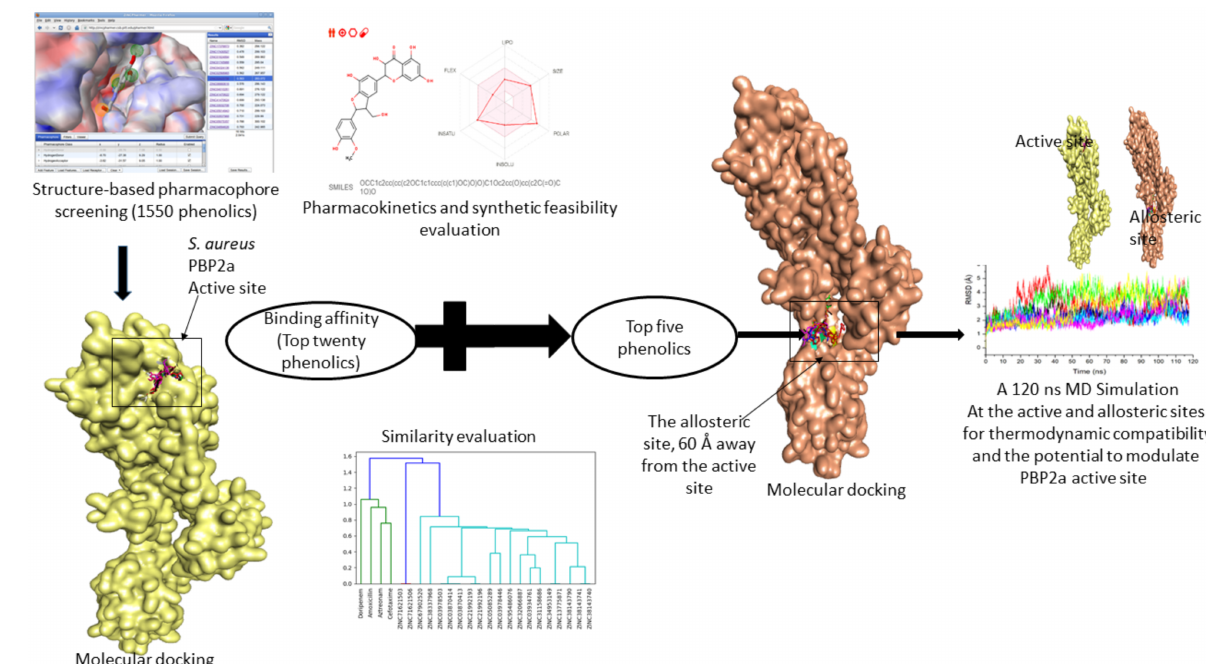
Figure 1. Workflow of the strategy